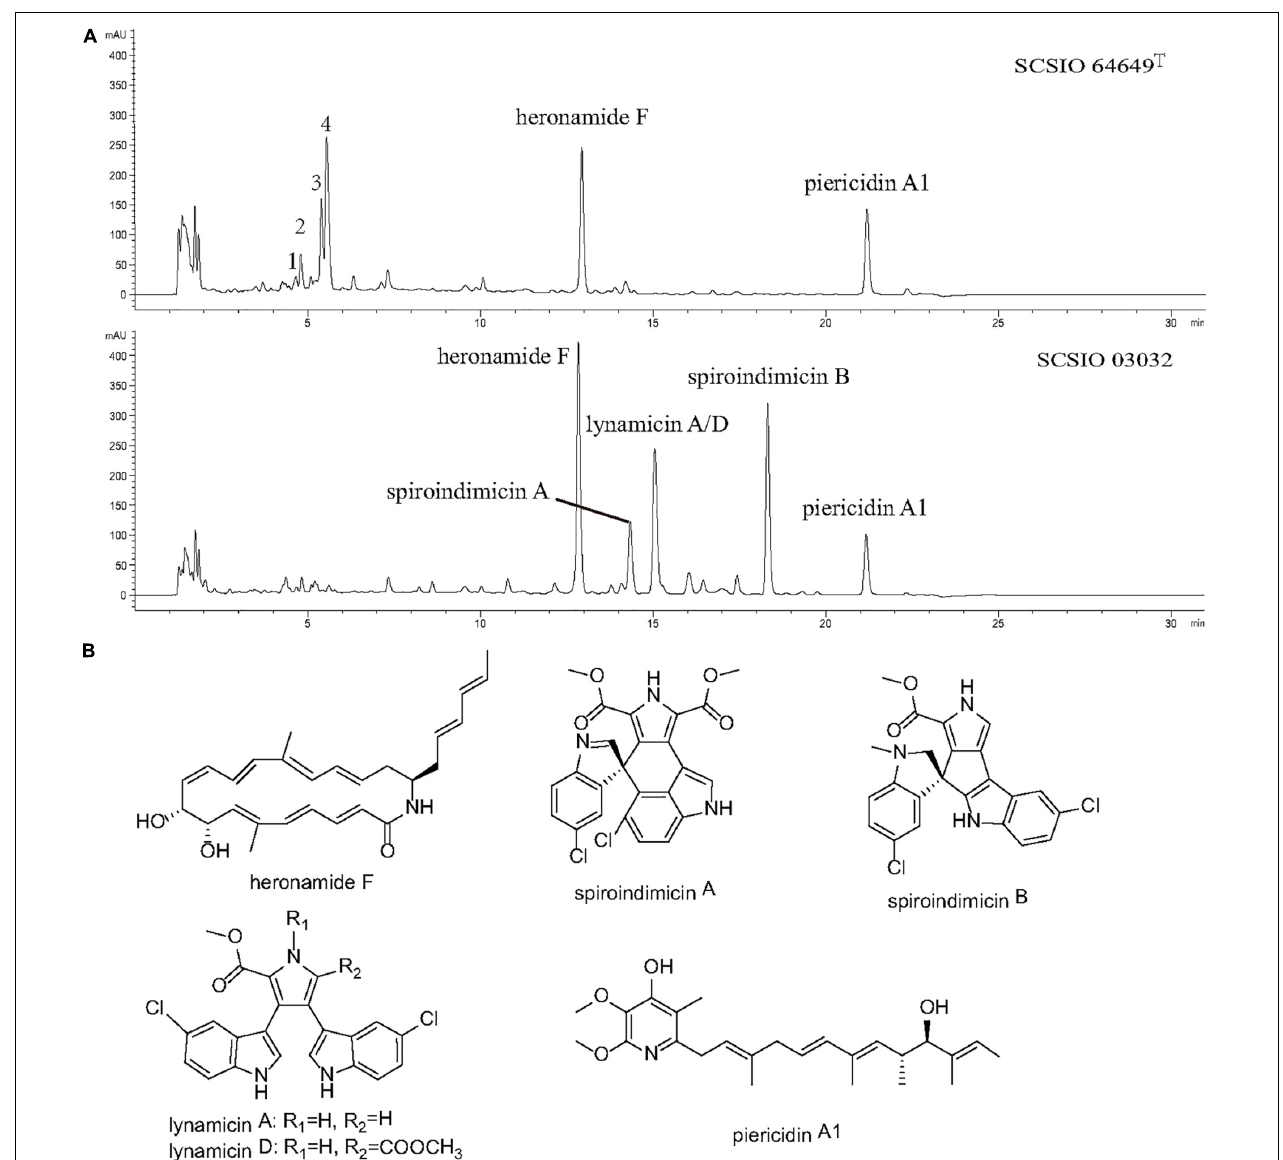
FIGURE 6 | (A) LC-DAD isoplot of the analyzed extract showing compounds produced. (B) Structural formula of compounds isolated from strains SCSIO 64649 T and SCSIO